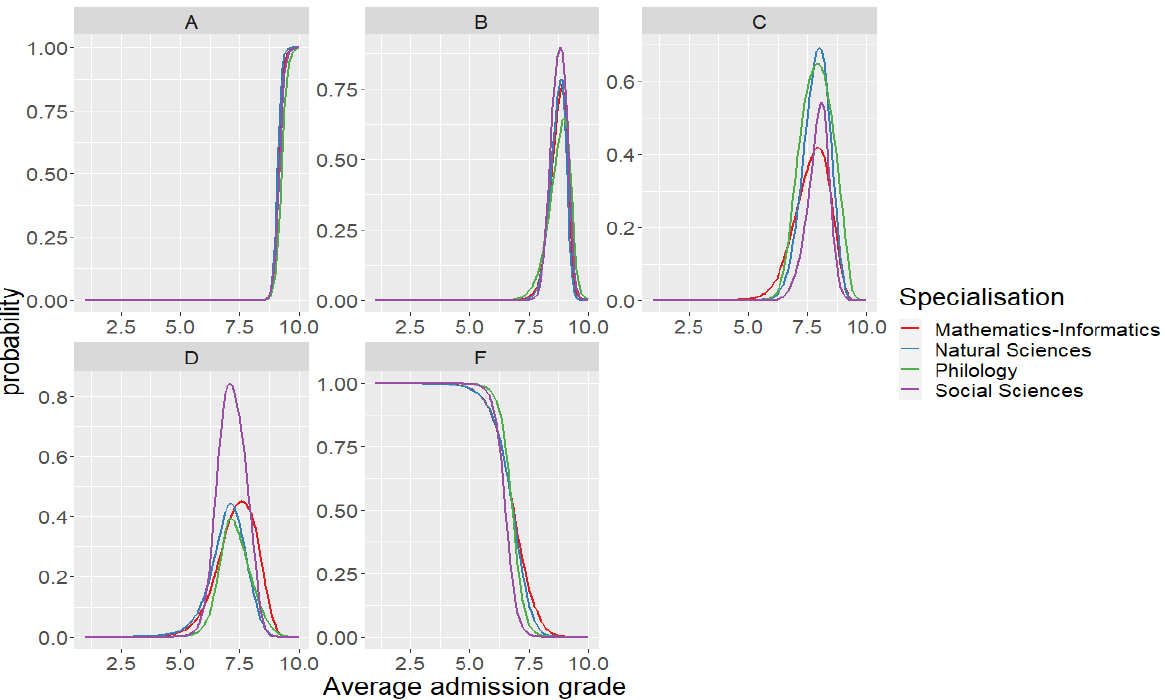
Figure 8. Admission probabilities in Bucharest by average admission grades.